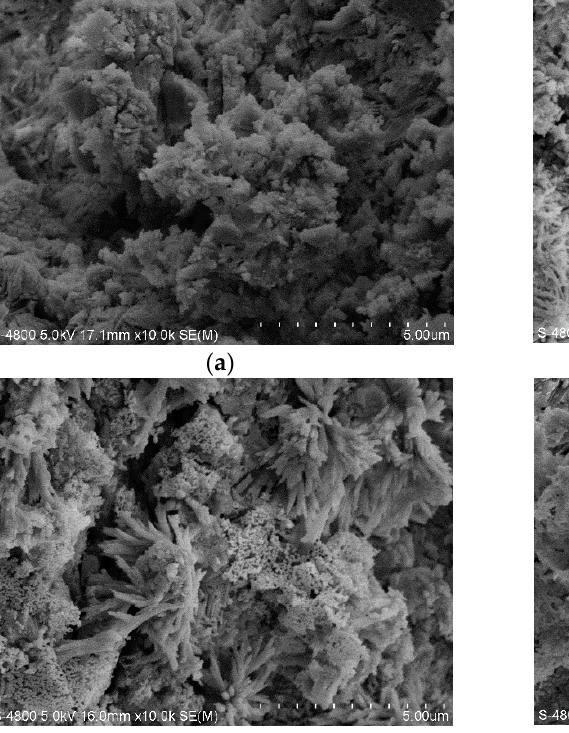
Figure 9. SEM images of cement pastes hydrated for 3 days. ( a ) 0%P 2 O 5 , ( b ) 0.5%P 2 O 5 , ( c ) 2.0%P 2 O 5 and ( d ) 2.5%P 2 O 5.